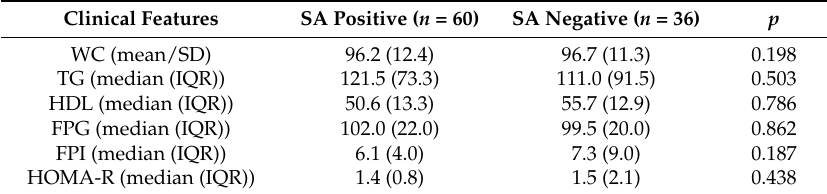
Table 2. Comparison of anthropometric and biochemical metabolic profile of WD GEP-NET patients under somatostatin analogues (SA positive) treatment versus patients with no somatostatin analogue exposure (SA